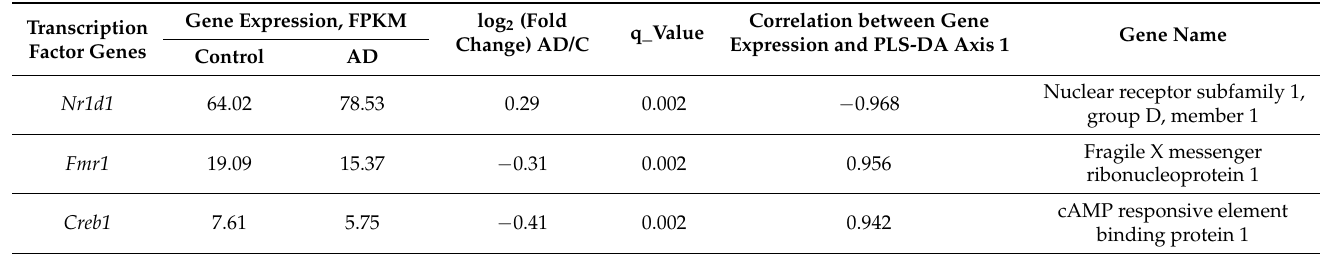
Figure 8. ( a ) Axes maximizing the distances between control and AD mice (males with consecutive 20 days of wins in daily agonistic interactions and then deprived of fighting for 14 days). ( b ) Distri- bution of expressed genes along the axis representing the correlation between gene expression and PLS-DA Axis 1. DEGs: differentially expressed genes. Table 5. DEGs encoding transcription factors that make the largest contribution (r > |0.90|) to C_AD differences.